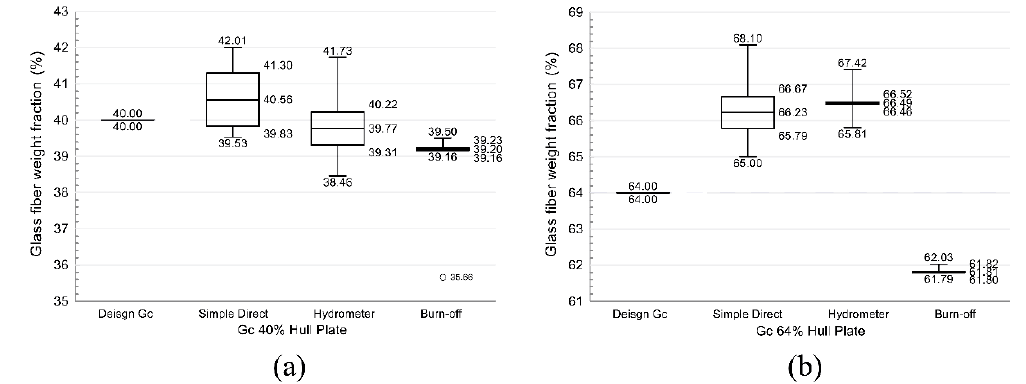
Figure 16. Gc distribution of specimens measured by different methods: ( a ) design Gc 40 wt.%; ( b ) design Gc 64 wt.%.